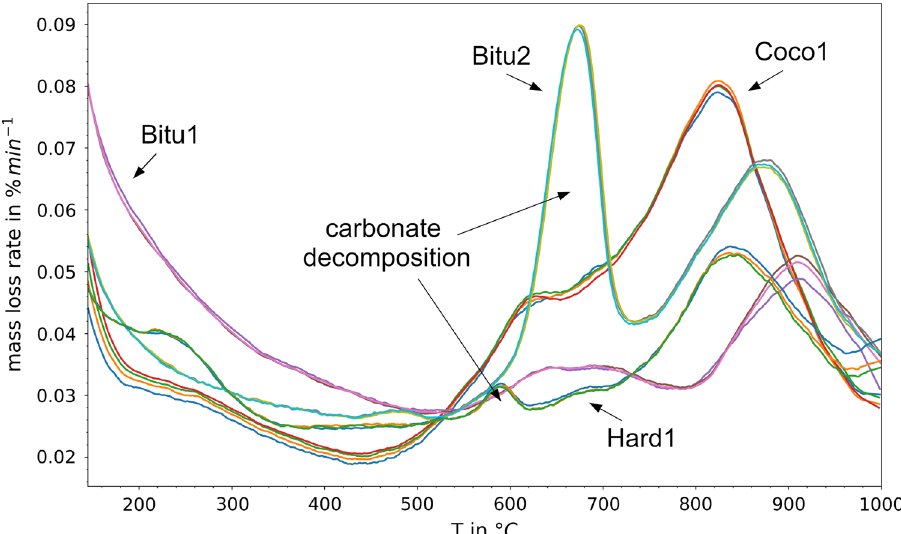
◦ C (ML 600 ) and the point of zero charge (PZC)